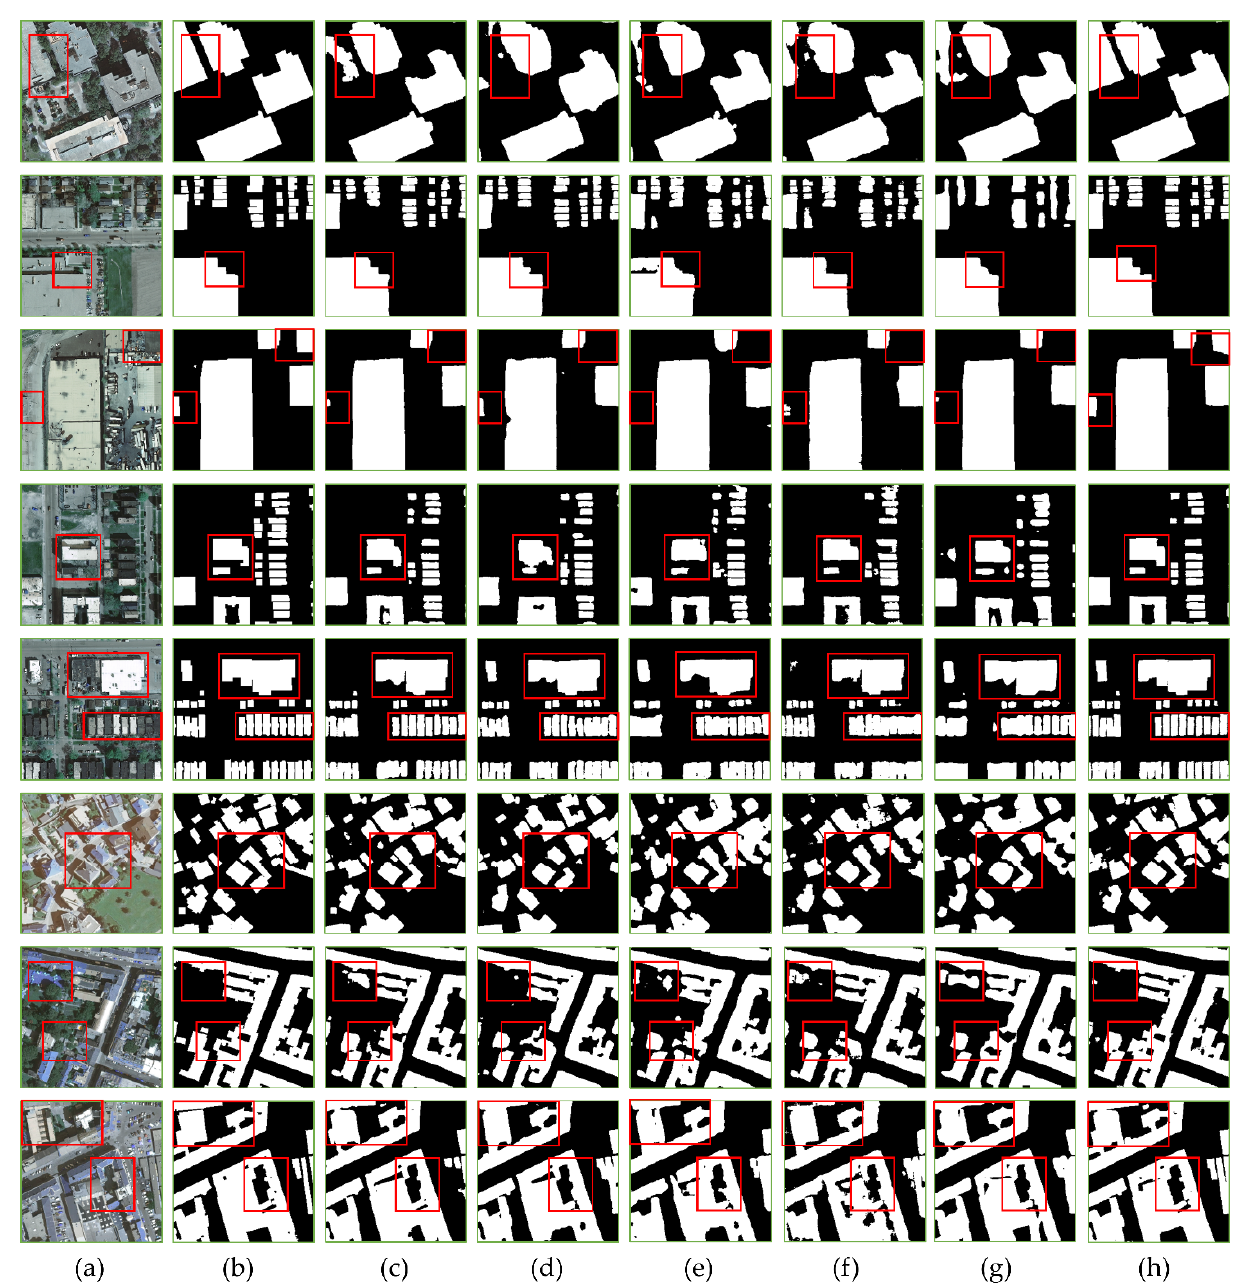
Figure 13. The extraction results of different methods on the INRIA aerial image labeling dataset. ( a ) Original images, ( b ) labels, ( c ) U-Net, ( d ) Res-UNet, ( e ) LinkNet, ( f ) SegNet, ( g ) DeepLabV3, ( h ) B-FGC-Net.